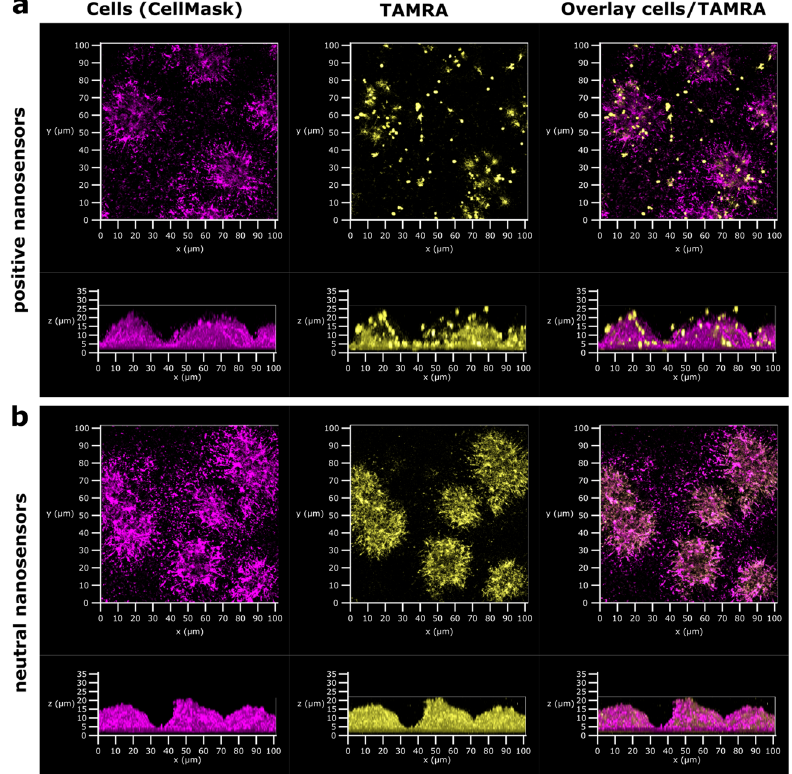
Fig. 3 Penetration of established P. aeruginosa bio fi lms by nanosensors under fl ow conditions was independent of the charge of the nanosensors. P. aeruginosa bio fi lms were initially grown for 12 h without nanosensors before the medium was switched to medium with 5mg mL − 1 positive ( a ) or neutral ( b ) nanosensors for 5h followed by a switch back to medium without nanosensors for another 5h. Confocal images show nanosensor fl uorescence (TAMRA, yellow) within the bio fi lm after the fi nal wash step for both nanosensors (positive and neutral). For the purpose of these images TAMRA has been false coloured to yellow to facilitate visualisation of nanoparticle